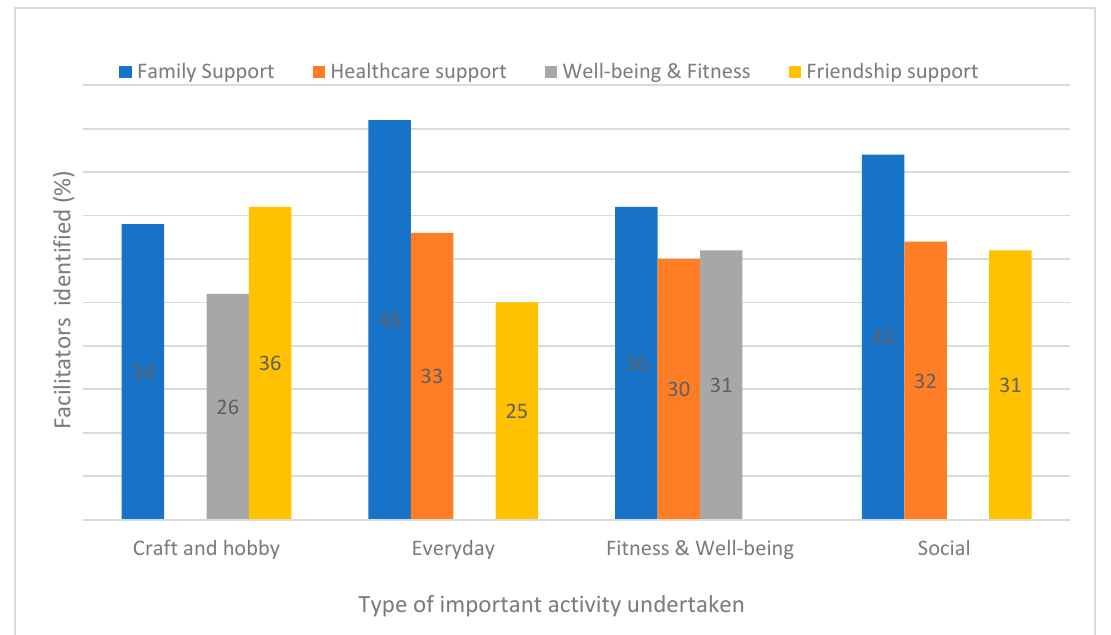
Figure 6. Top three reported facilitators to activity (%) at 6 month follow-up by type of important activity undertaken.